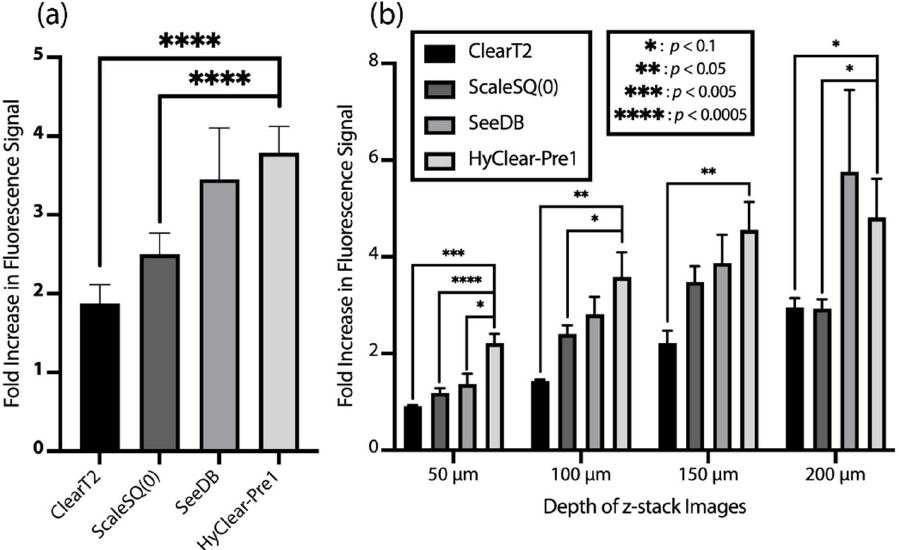
Figure 3. ( a ) The average overall fold increase of the fluorescence signal in the centre of the spheroids (in depths between 50 to 200 µ m) in different clearing methods adapted for microtissues [3] versus HyClear-Pre1. ( b ) The average fold increase in the fluorescence signal after clearing in different imaging depths using some of the common clearing methods versus HyClear-Pre1. The significances are calculated using a heteroscedastic two-tailed t -test. The error bars represent the standard error of the mean.